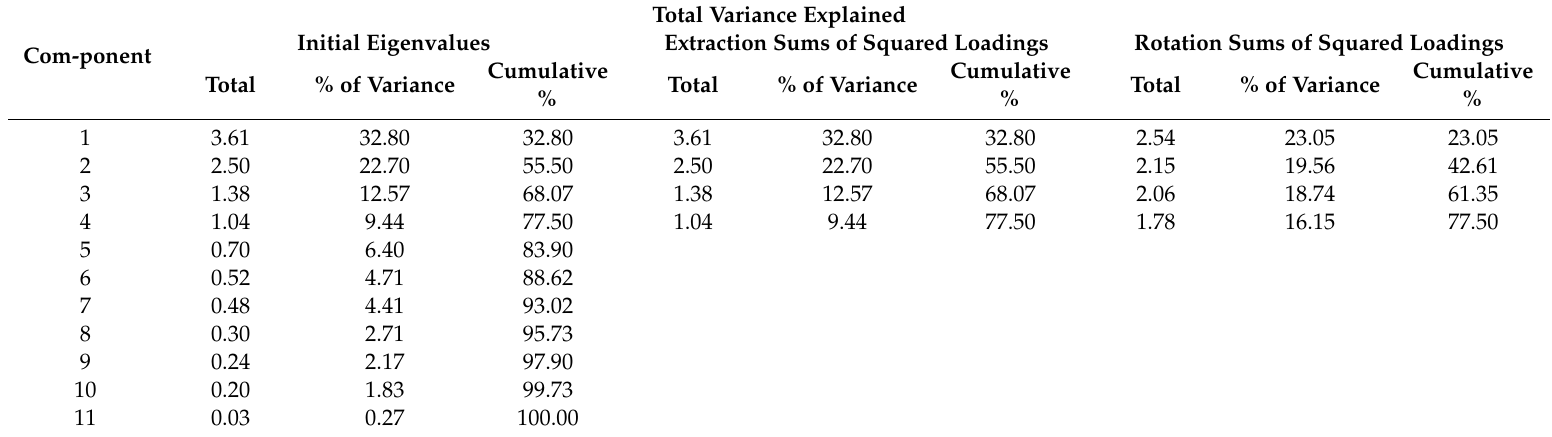
Table 5. The number of extracted factors, eigenvalues, and percentages of variance